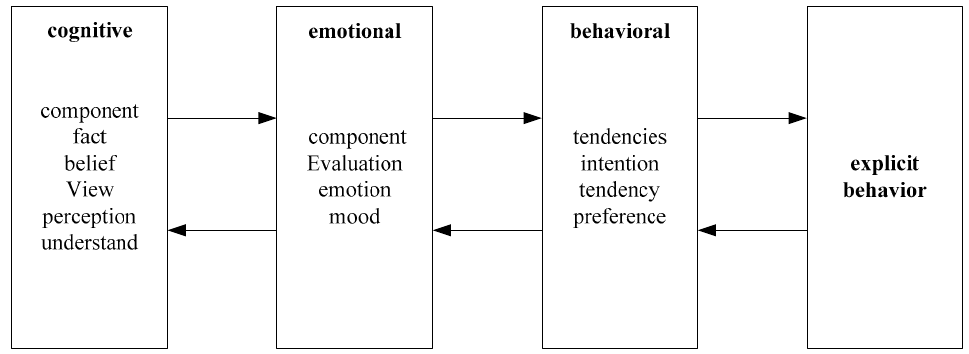
Figure 6. Attitude components and their relationships.